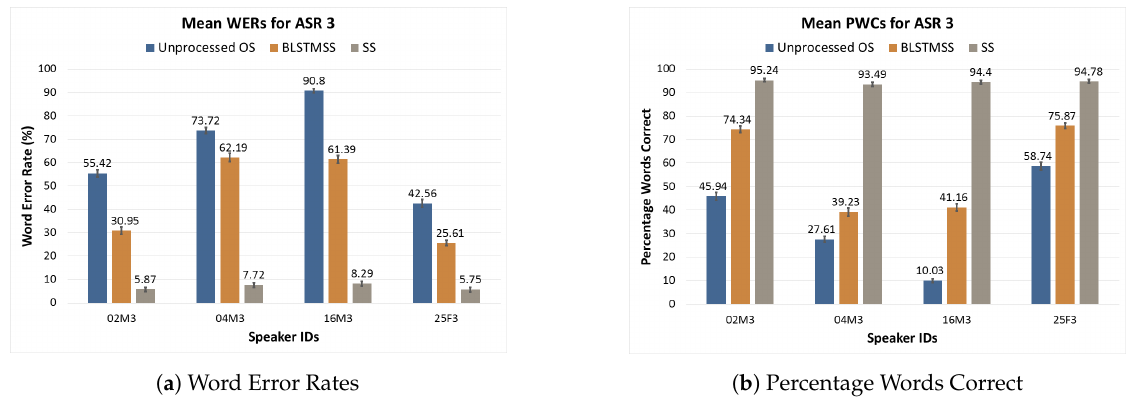
Figure 4. ASR 3 WER and PWC scores for unprocessed OS (source), the BLSTMSS converted outputs and target SS (target). Error bars show standard